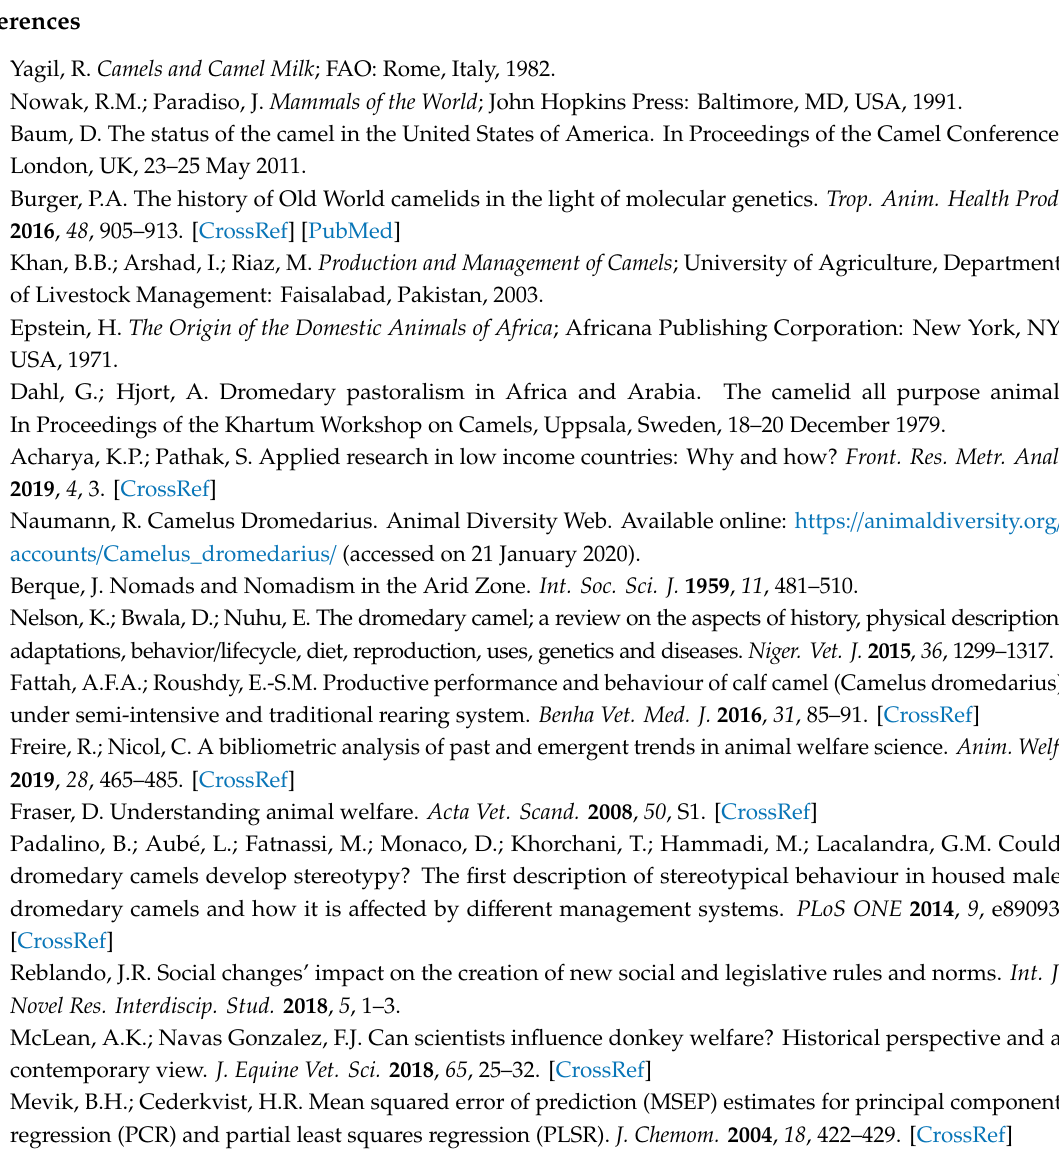
Table S1. Results of Shapiro–Francia W’ test with log transformation [51], Table S2. Spearman’s rank-order correlations between impact factor related variables for camel research